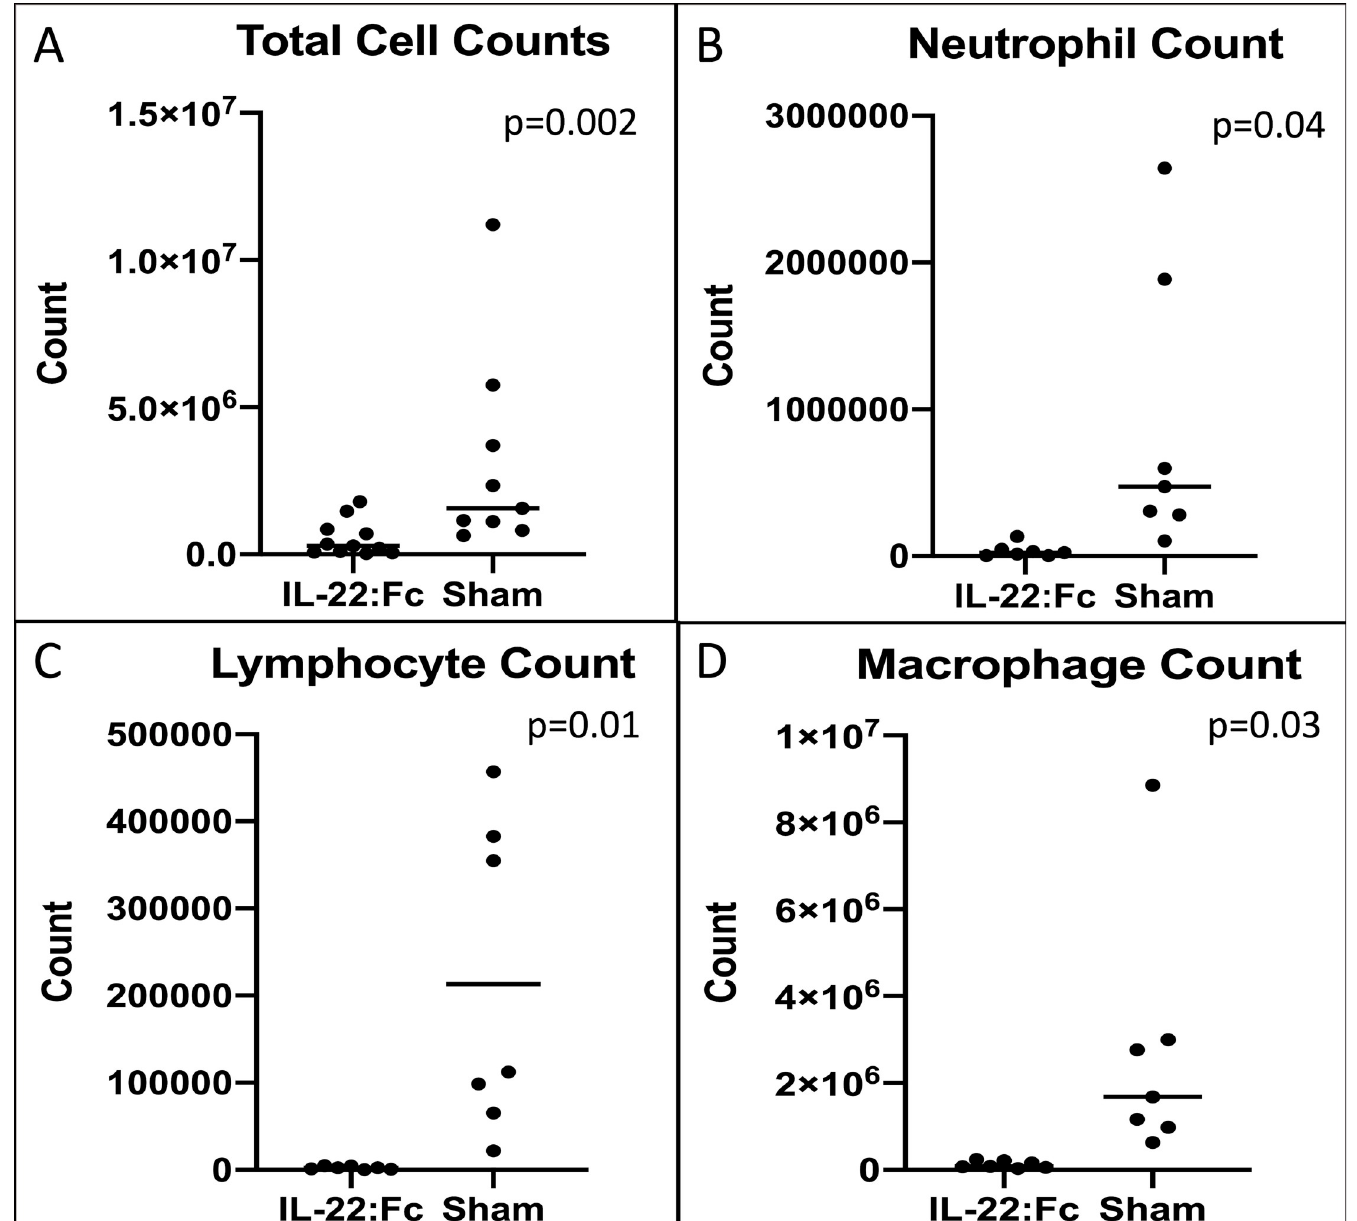
Fig 2. Cellular influx after high-dose LPS lung injury. Mice with high-dose LPS injury have decreased cellular influx into the lungs when treated with IL-22:Fc as shown in BAL cell counts. IL-22:Fc treated mice have decreased A) total cell counts, B) neutrophil counts, C) lymphocyte counts, and D) macrophage counts. IL-22:Fc was lower than sham animals (0.15 vs. 0.25 ug/uL, p = 0.03). A comparison of histo- pathology scores among animals with low dose LPS injury did not show any difference in his- topathology scores. After high-dose LPS injury, BAL protein in animals receiving IL-22:Fc was not different compared to sham (0.55 vs. 0.38 ug/uL, p = 0.18). A comparison of histopathology scores of high-dose LPS inured animals (Fig 4A) showed that IL-22:Fc treated animals had less severe